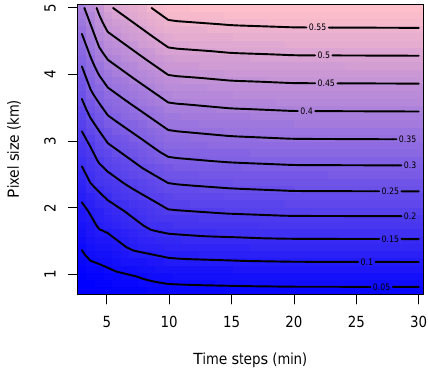
Figure 5. Indicated with curves as well as colors are the fractions of pixels containing at least one measurement of the unfiltered dataset for combinations of time step length and pixel grid size over the Amsterdam area between December 2014 and April